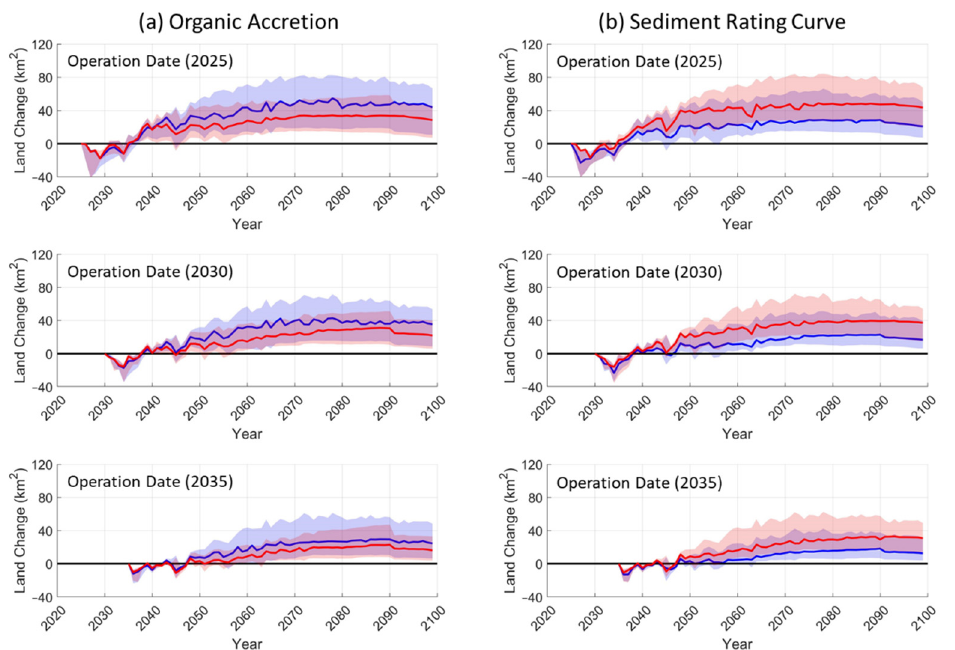
Figure 4. Effect of organic accretion and mineral sediment rating curves on net land change. Panel ( a ) is for organic accretion rates where the blue line represents the 5-mm rate and the red line represent the mineral only permutations. Panel ( b ) is for the mineral sediment rating curves where the blue line represents the USGS rating curve, while the red line represents the HYST rating curve. The top row is assuming operation date of 2025, while the middle row is for 2030, and the bottom row is for 2035.